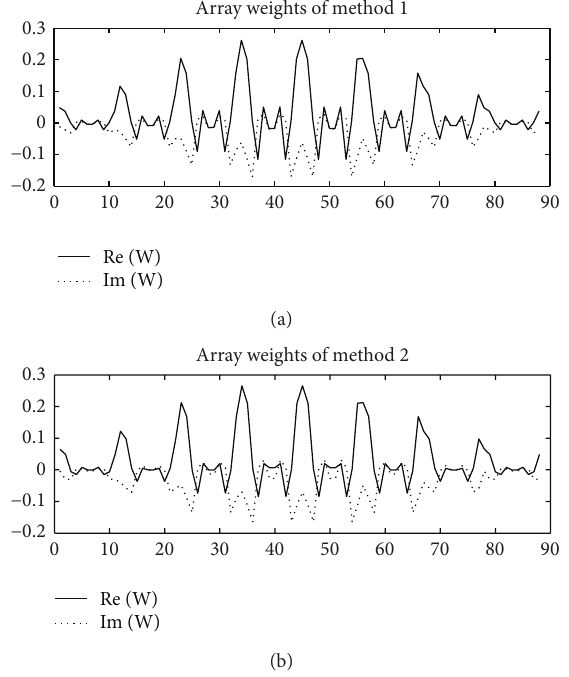
Figure 9: Normalized weights of the cylindrical